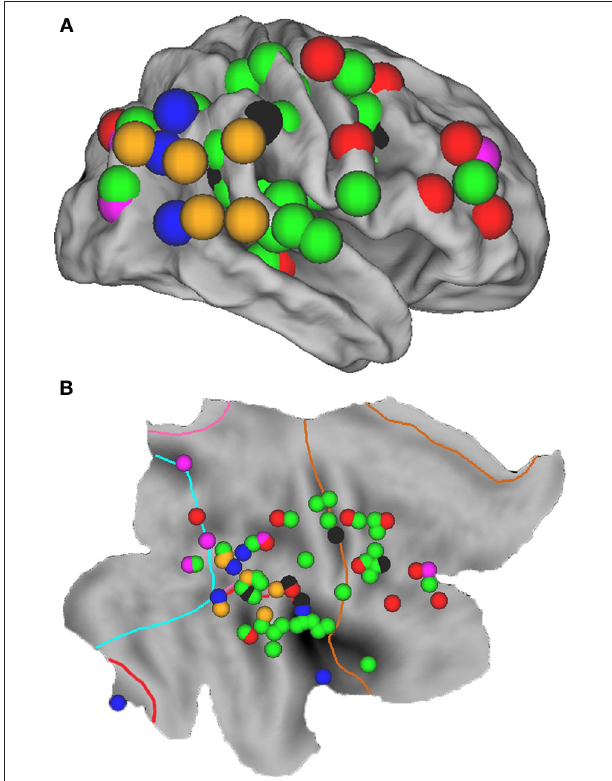
FIGURE 1 | Overview of all regions associated with unilateral spatial neglect, based upon 20 lesion mapping studies (see Table 1), superimposed on the cortical surface of the right hemisphere using CARET software (v5.64 http://brainmap.wustl.edu/caret.html). (A) Fiducial map. Purple spheres = neglect tested with line bisection tasks; red spheres = neglect tested with cancellation tasks; green spheres = neglect tested with a combination of tasks; blue spheres = allocentric neglect; black spheres = personal neglect; orange spheres = spatial extinction. (B) Flat map with identical spheres as in A. Cyan line indicates the occipital lobe border; pink line = parietal lobe; red line = temporal lobe; brown line = frontal lobe; regions outside borders = limbic